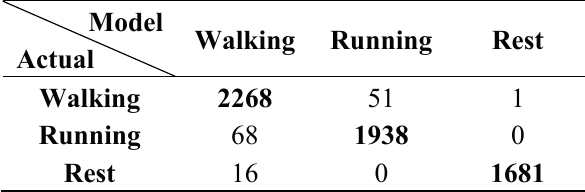
Table 8. Confusion matrix of J48 decision